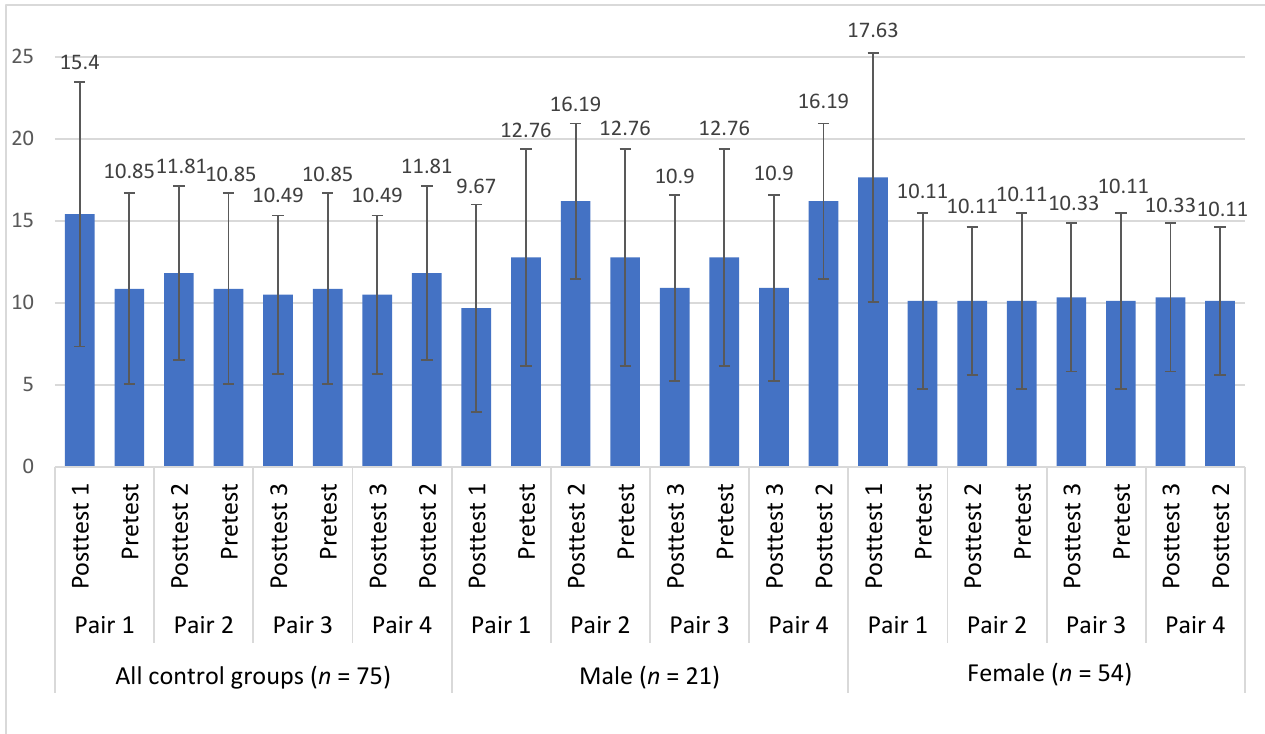
Figure 3. Mean Differences Between Paired Tests Within the Control Groups.